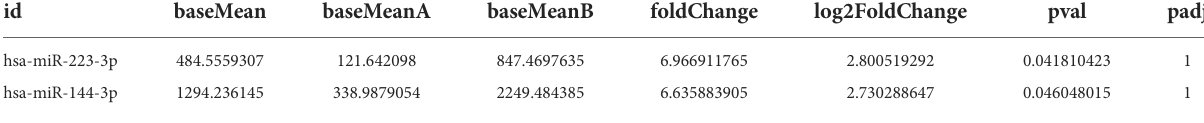
TABLE 1C Two miRNA expressions signi fi cantly upregulated in wound of diabetic patients. id